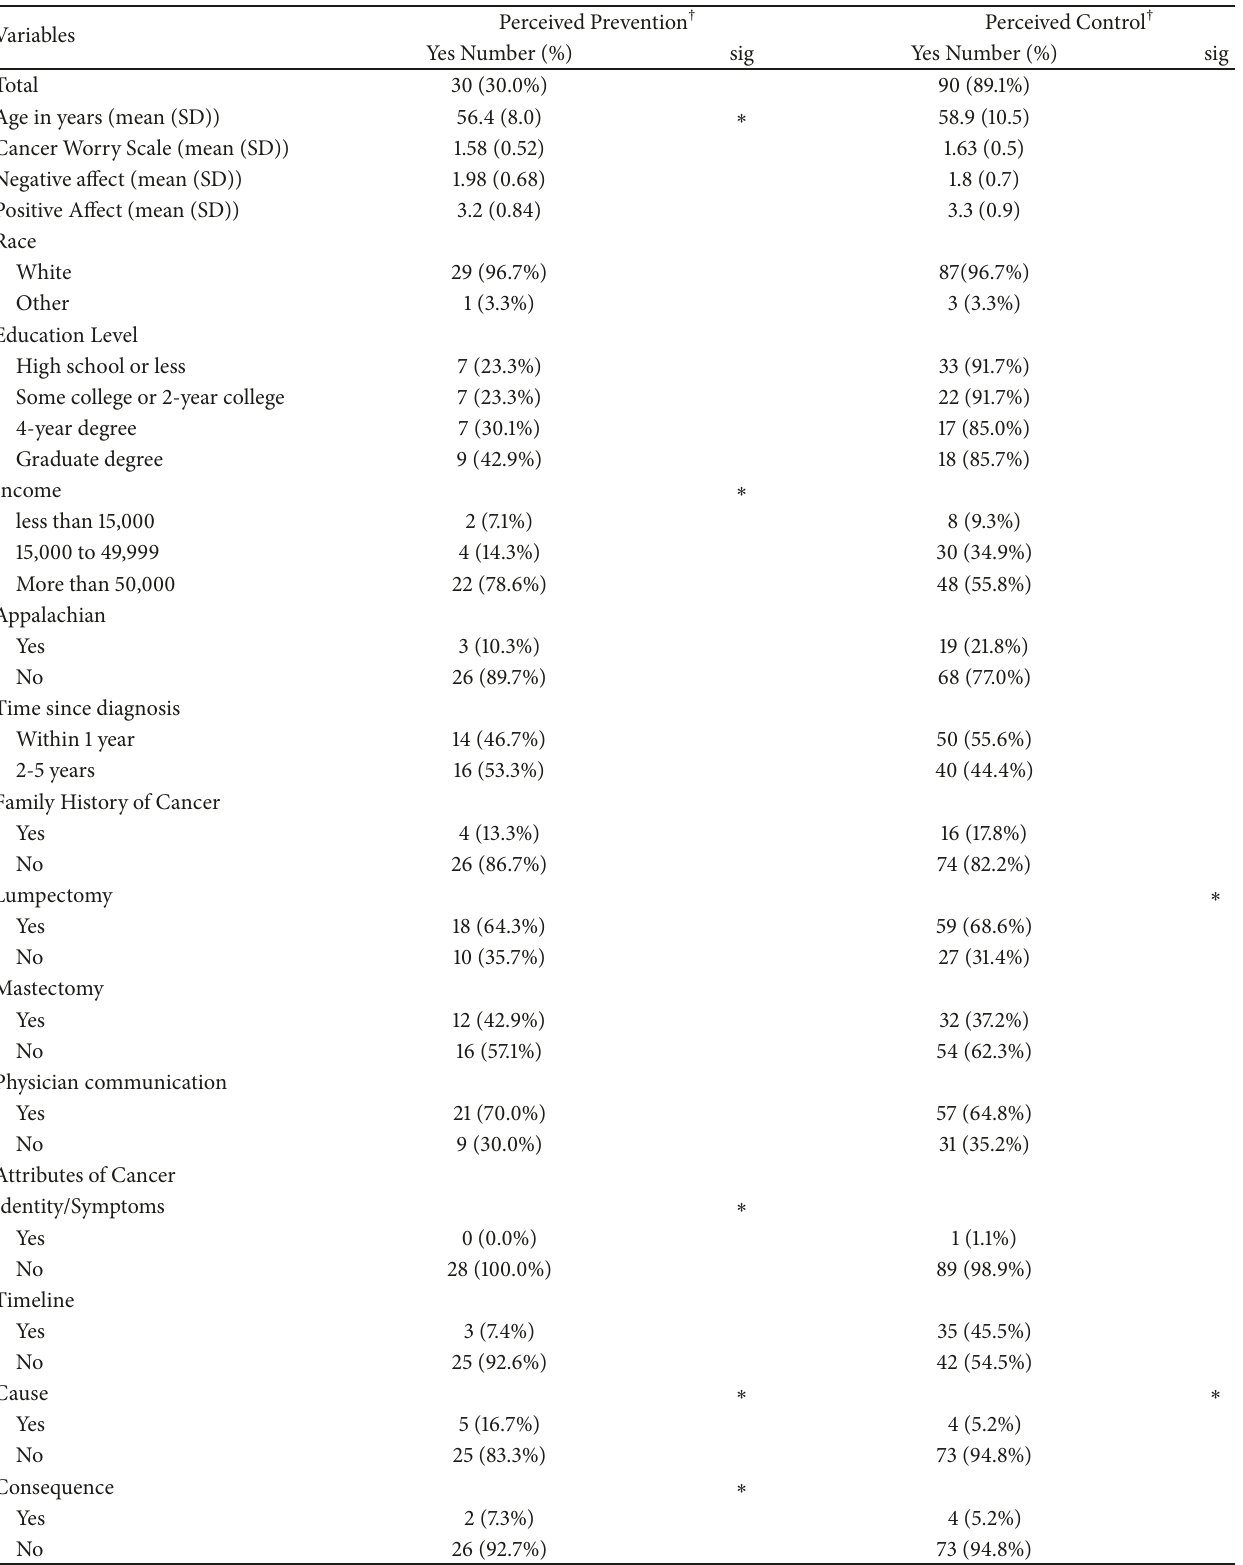
Table 3: Sample characteristics for perceived prevention of future cancer recurrence and perceived control of progression following future cancer